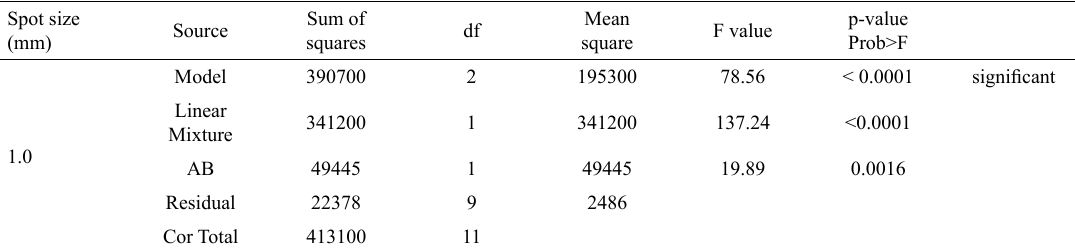
Table 4. ANOVA analysis of hardness response for laser cladding of grey cast iron with Cr and Mo powders addition. Spot size (mm)